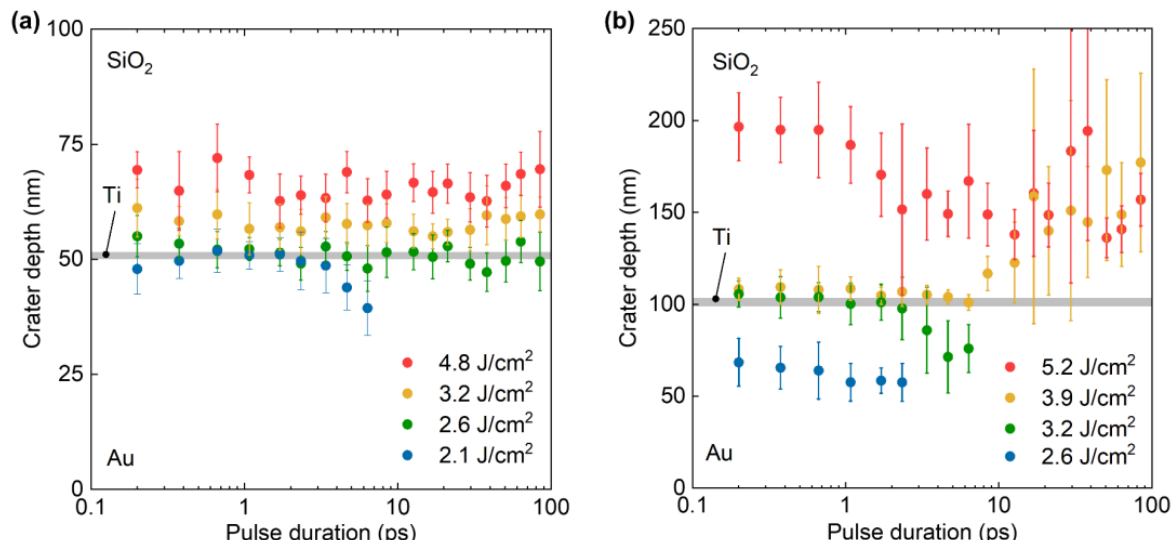
Figure 4. Distributions of crater depths fabricated by single-pulse ablation as a function of the pulse duration. ( a ) 50 nm- and ( b ) 100 nm-thick Au films; ( b ) has been reproduced from [17] under permission of Springer Nature, 2021. Standard deviations for 10 craters are indicated as error bars. The range of pulse duration shorter than 10 ps is found suitable for selective ablation of 100 nm-thick Au film.